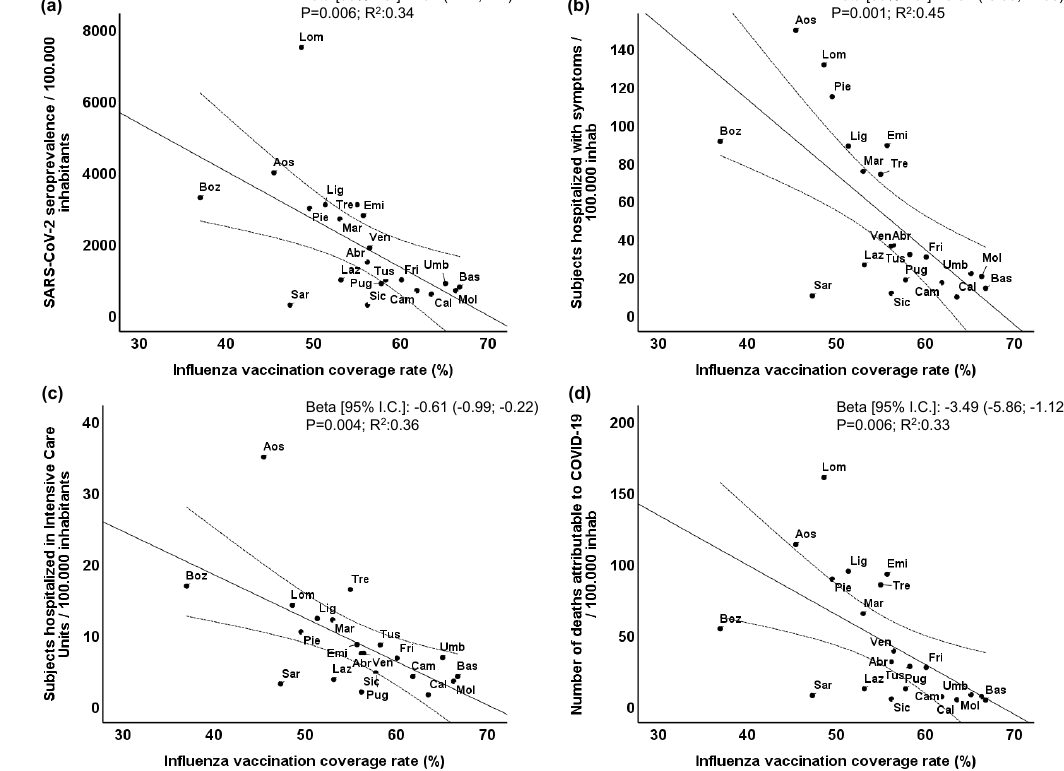
Figure 2. Univariate correlations between the influenza vaccination coverage rate and ( a ) seroprevalence for COVID-19, ( b ) patients hospitalized with symptoms, ( c ) patients hospitalized in intensive care units or ( d ) number of deaths attributable to COVID-19. Abr = Abruzzo; Aos = Aosta Valley; Bas = Basilicata; Boz = Bozen A.P.; Cal = Calabria; Cam = Campania; Emi = Emilia Romagna; Fri = Friuli Venezia Giuli; Laz = Lazio; Lig = Liguria; Lom = Lombardy; Mar = Marche; Mol = Molise; Pie = Piedmont; Pug = Puglia; Sar = Sardinia; Sic = Sicily; Tre = Trento A.P.; Tus = Tuscany; Umb = Umbria; Ven =